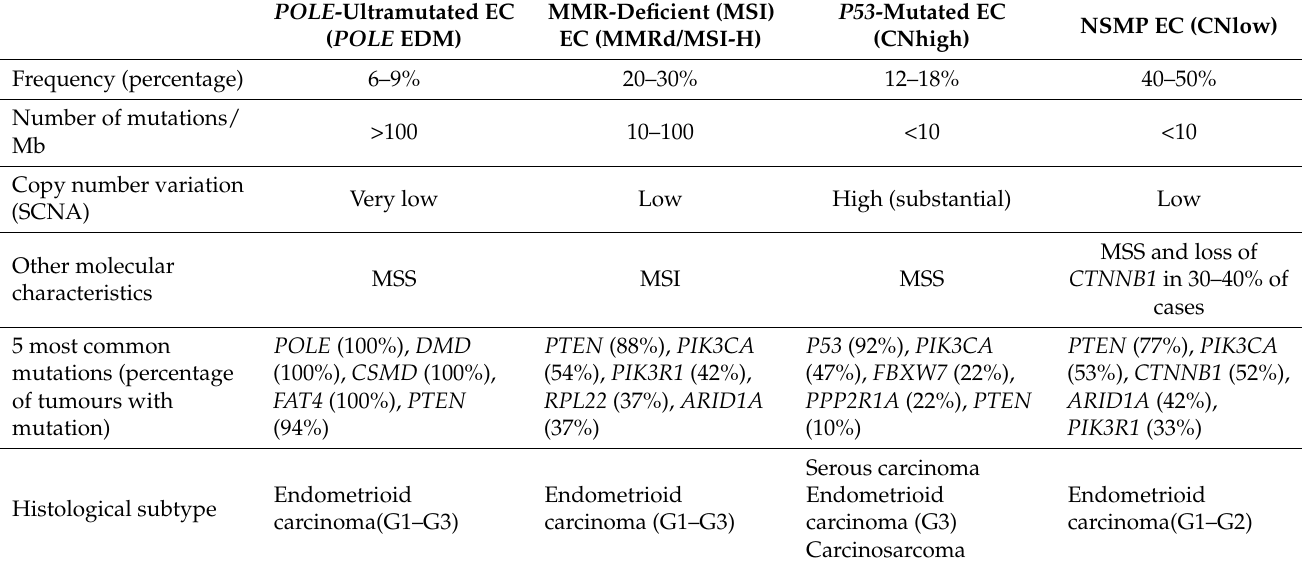
Table 4. Molecular classification of the carcinoma of the endometrium (refers to endometrioid carcinoma, EEC; serous carcinoma; and